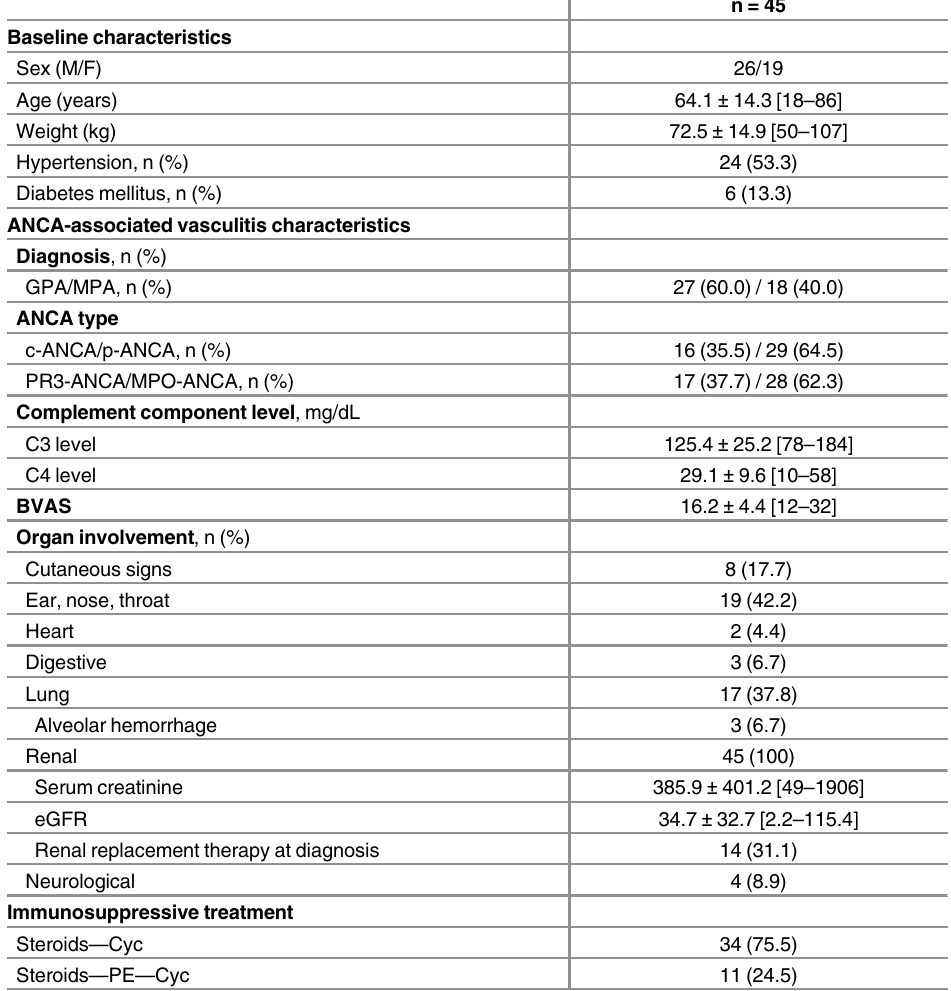
Table 1. Clinical and biological presentation at AAV